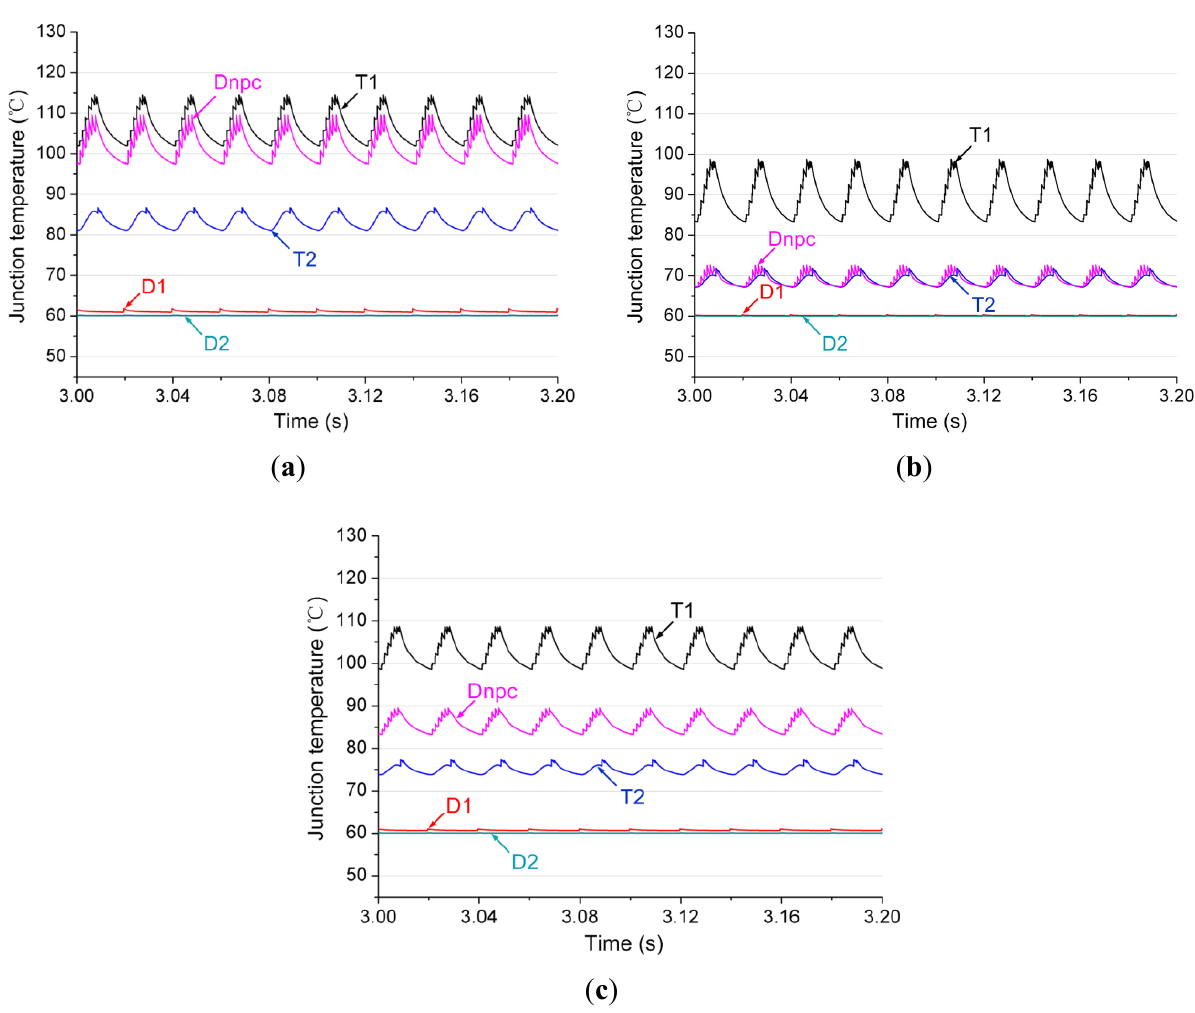
Figure 11. Thermal cycling of the 3L-NPC inverter with different switching device solutions (normal operation condition in Figure 9). ( a ) IGCT presspack solution; ( b ) IGBT presspack solution and ( c ) IGBT module